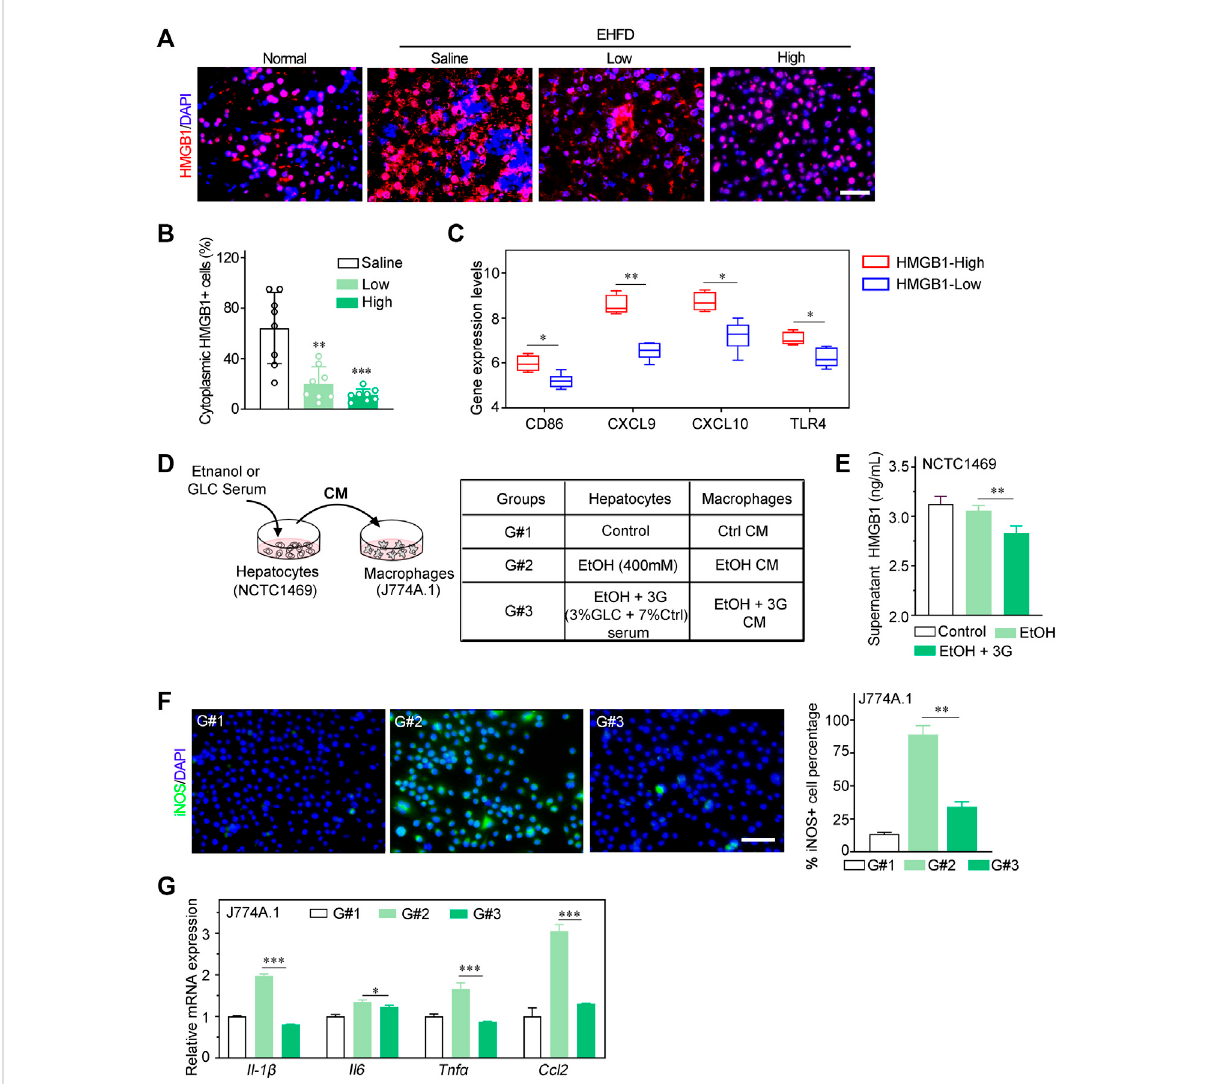
FIGURE 5 GLC blocks M1 polarization by decreasing HMGB1 released by hepatocytes. (A) Immuno fl uorescence staining of HMGB I in mouse liver tissues. Scale bars, 50 μ m. (B) Statistics of cytoplasmic HMGB1 positive cells of IF staining sections (C) Dataset (GEO database- GSE28619) of patients with alcoholic hepatitis were analyzed. Expression levels of M1 related markers (CD86, CXCL9, CXCL1 0 and TLR4) in HMGB1-High group and HMGB1-Low group. (D) Schematic fl owchartofco-culturesystem.NCTC1469cellsinducedbyEtOHwithorwithouttreatmentofGLCserum.Supemetantwascollectedfor ELISA and culturing macrophages. The treatment of NCTC1469 cells was displayed in table (E) Supernatant HMGB1 levels of NCTC1469 cells induced by EtOH.** P < 0.01vs.theNCTC1469cellswithEtOHtreatment. (F) RepresentativeiNOSimmuno fl uorescencestainingandstatisticsofmacrophagestreated with conditionmedium (CM) of NCTC1469 cells. Scale bars, 50 μ m. (G) QuantitativePCR analysisof J774A.1 cell cocultured withNCTCI469 cells. The data were obtained from three dependent experiments per group. * P < 0.05 vs. G#1, *** P < 0.001 vs.